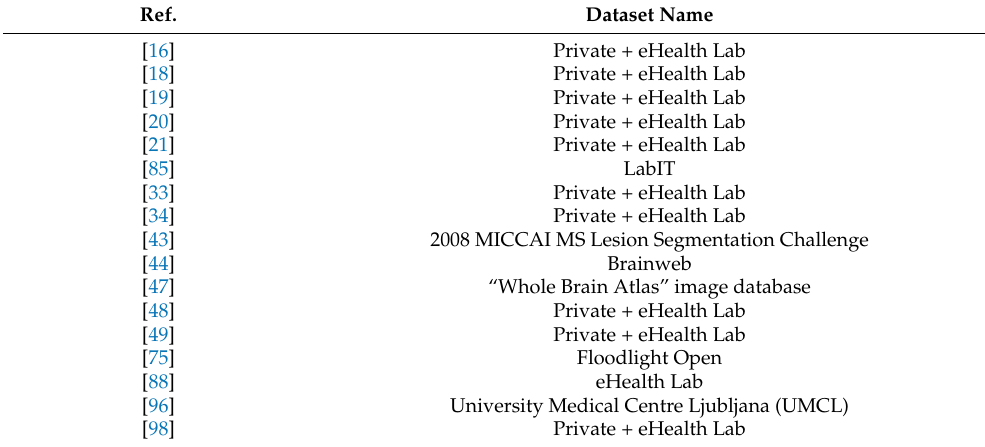
Table 3. Publicly available